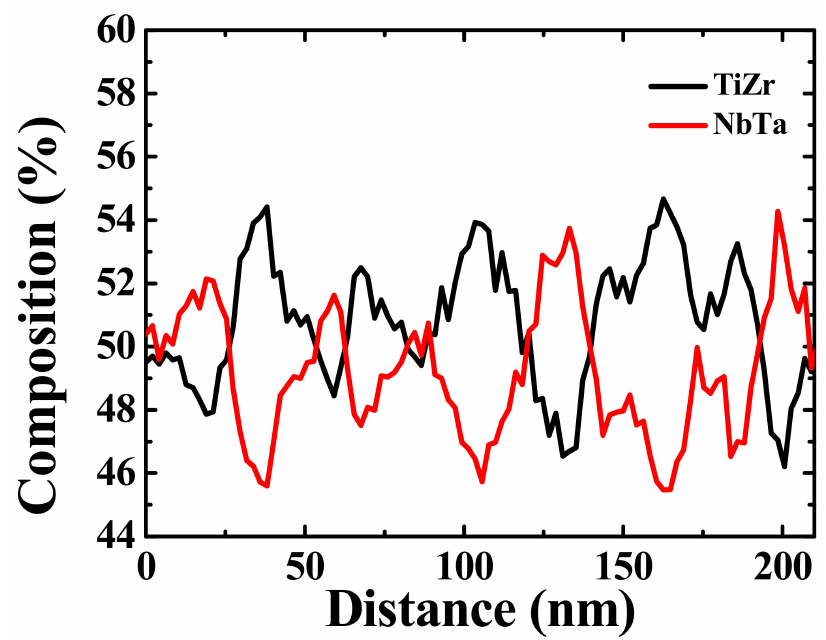
Figure 7. STEM-EDS line scan result of the spinodal interconnected structure along the red line of Figure 6c in the as-homogenized alloy.